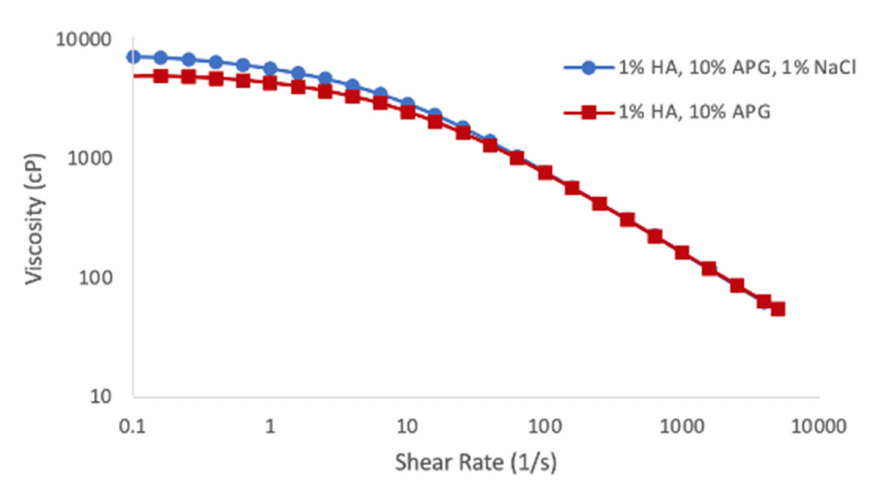
Figure 6. Effect of NaCl concentration for HA + APG on viscosity vs. shear rate.